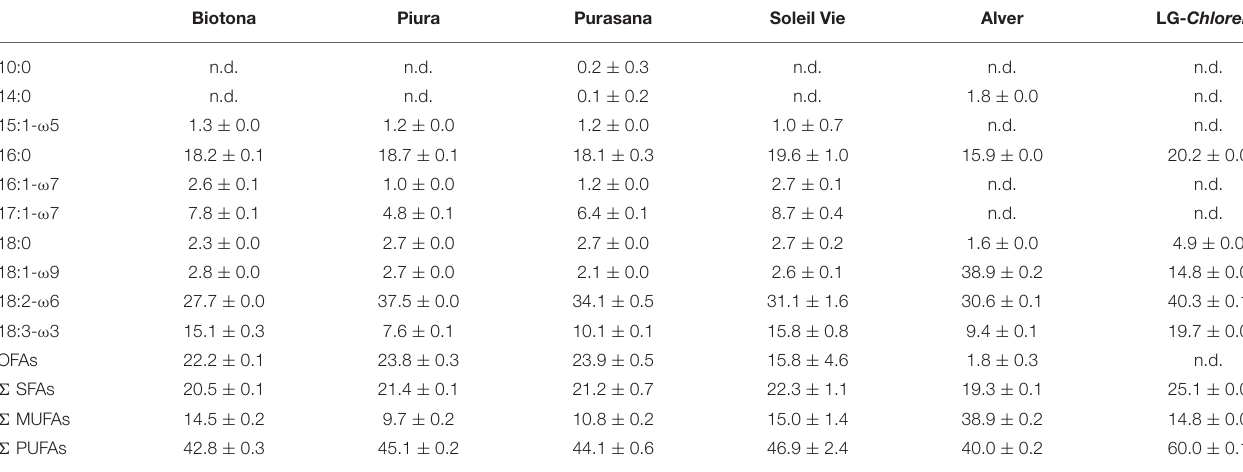
TABLE 3 | Fatty acid profile of commercial microalgae biomasses and LG- Chlorella